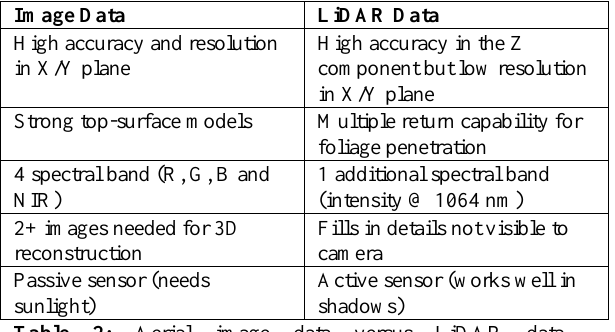
Table 2: Aerial image data versus LiDAR data - complementary benefits